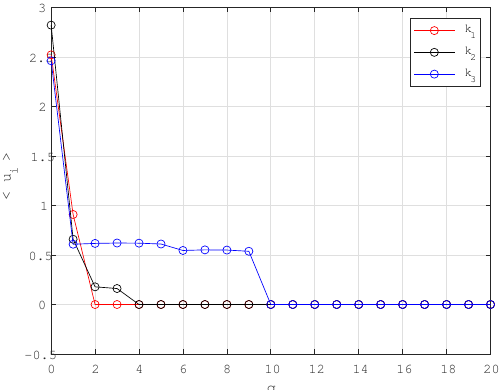
Figure 6. Dependence of the average subpopulation size < u i > on the coupling strength, q , for different random carrying capacities, k ( 1 ) , k ( 2 ) , k ( 3 ) , and constant β = 6. A monotonous decrease in the average density is, however, only observed for a smaller value of the Allee threshold ( β = 6 in Figure 6). For a larger β , a change in < u i >